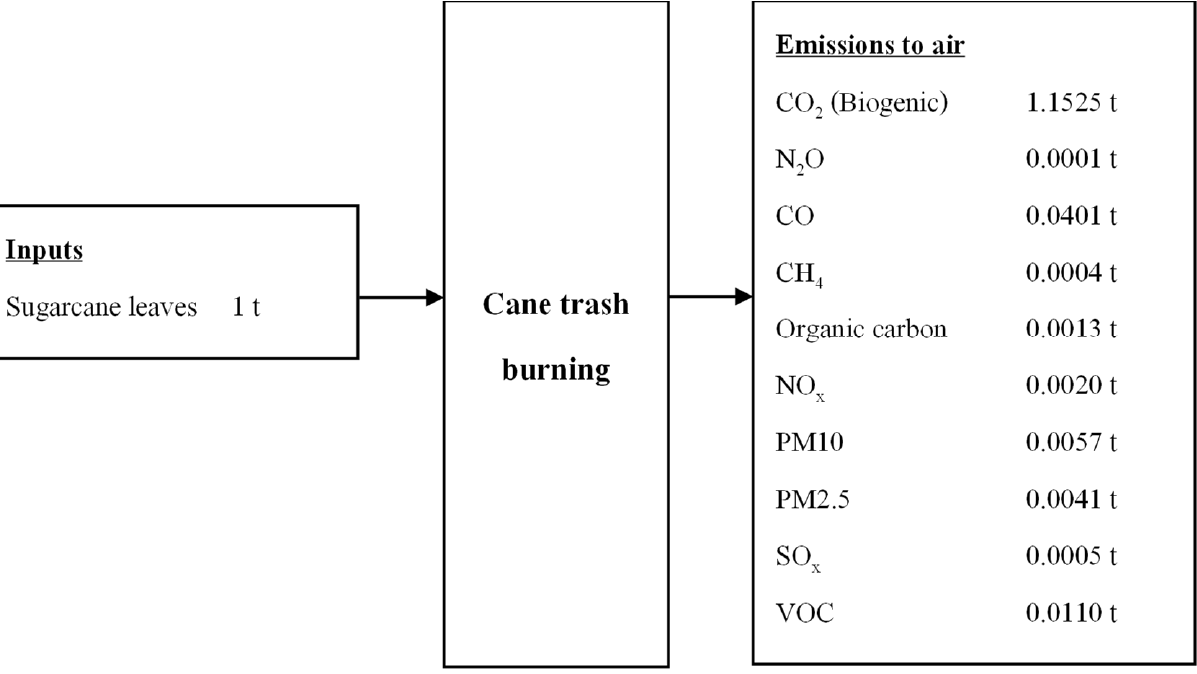
Figure A2. Inputs-Outputs for the sugarcane trash for electricity generation scenario (SL1). Remark: Emissions to air are calculated based on [43,44].